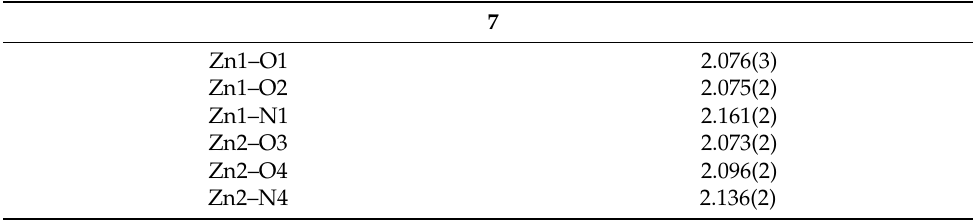
Figure 6. Linear chain in the crystal structure of compound 7 . Symmetry operation a = − x , 2 − y , 2 − z ; b = 2 − x , − y , 1 − z . Table 5. Selected bond lengths (Å) for compound 7